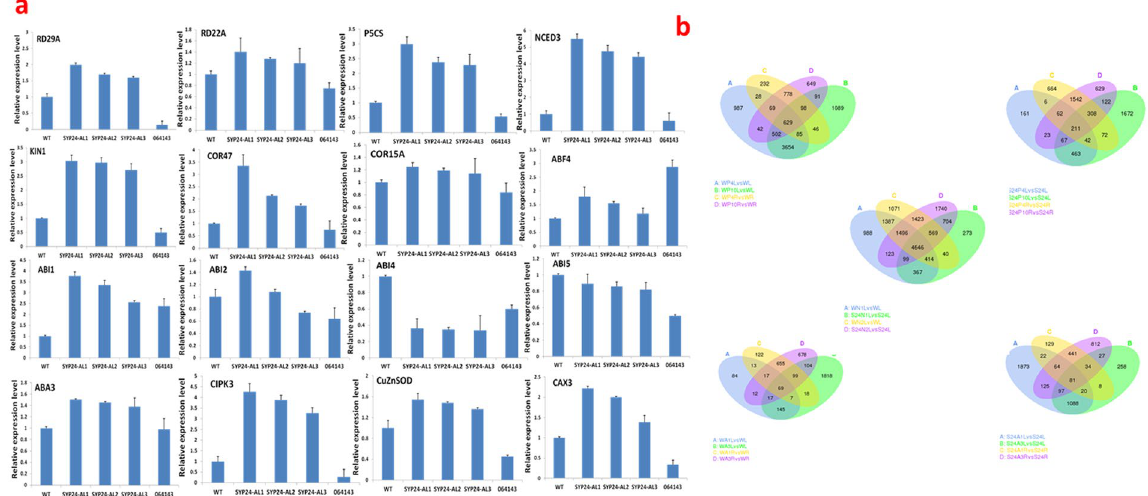
Figure 7. ( a ) The relative expression level of ABA or stomatal-relative genes in GmSYP24hx Arabidopsis plants. ( b ) Transcriptome analysis of transgenic and wild type soybean plants. Venn diagrams comparing the differentially expression genes under drought, salt or ABA